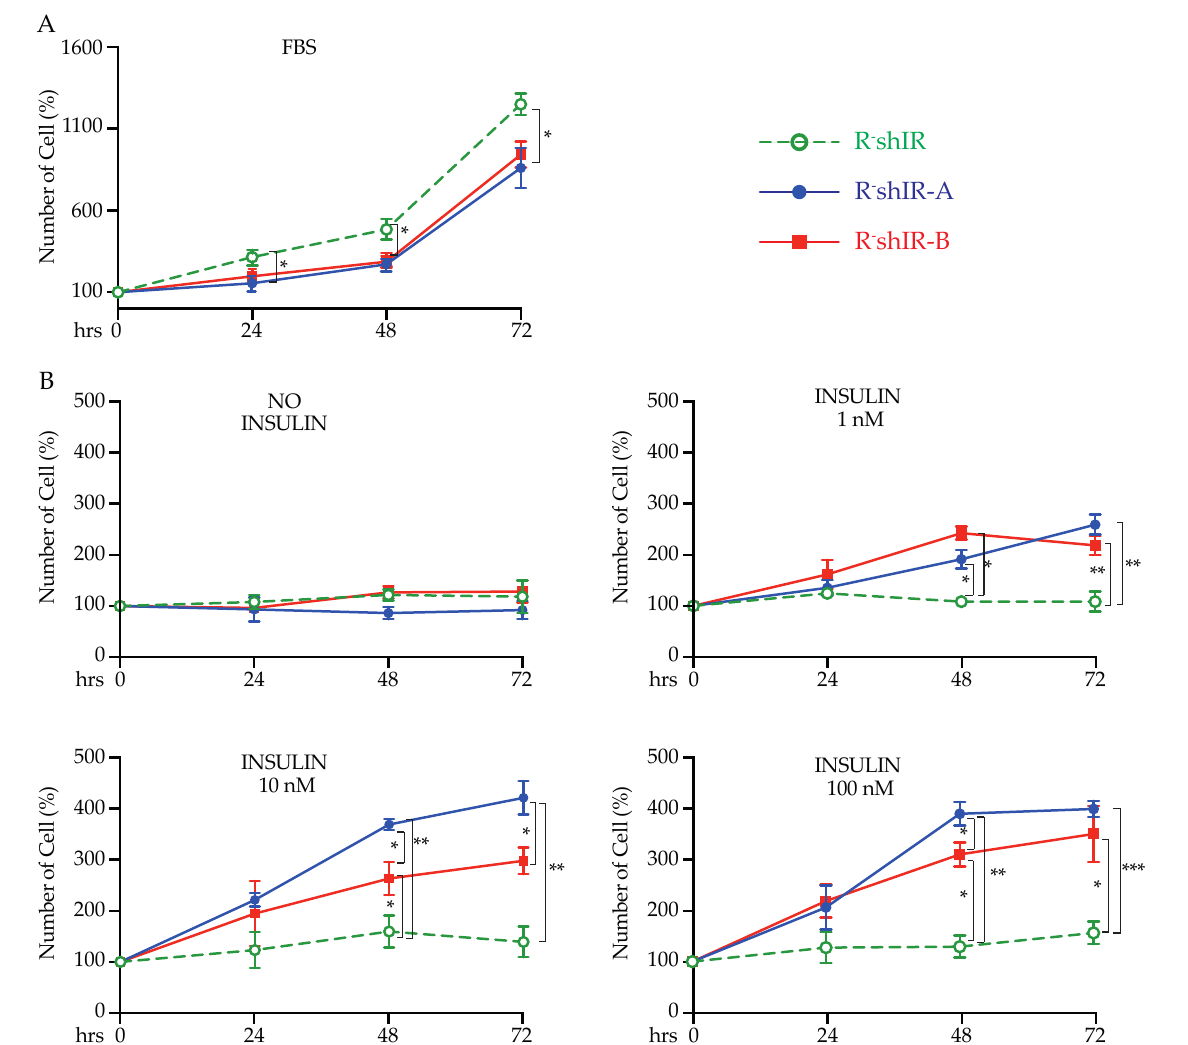
Figure 2. Insulin-free and insulin-occupied IR isoforms differently affect cell proliferation. In cells cultivated in the presence of doxycycline (1 µ g/mL) for 72 h, viability was measured by Trypan blue exclusion. Cell number at time 0 was considered 100%. Cells were cultivated in growth medium (DMEM supplemented with 10% FBS and 2 mM glutamine) (panel A ) or in DMEM supplemented with bovine serum albumin 0.1%, 2 mM glutamine and insulin 0, 1, 10 or 100 nM (panel B ). Cell numbers were measured every 24 h for three days. Bars indicate the standard deviation from two independent experiments performed in triplicates. Statistical analysis of variance (ANOVA) plus Bonferroni’s post-test were calculated using the GraphPad Prism software version 8.0. (* p < 0.05, ** p < 0.01, *** p <